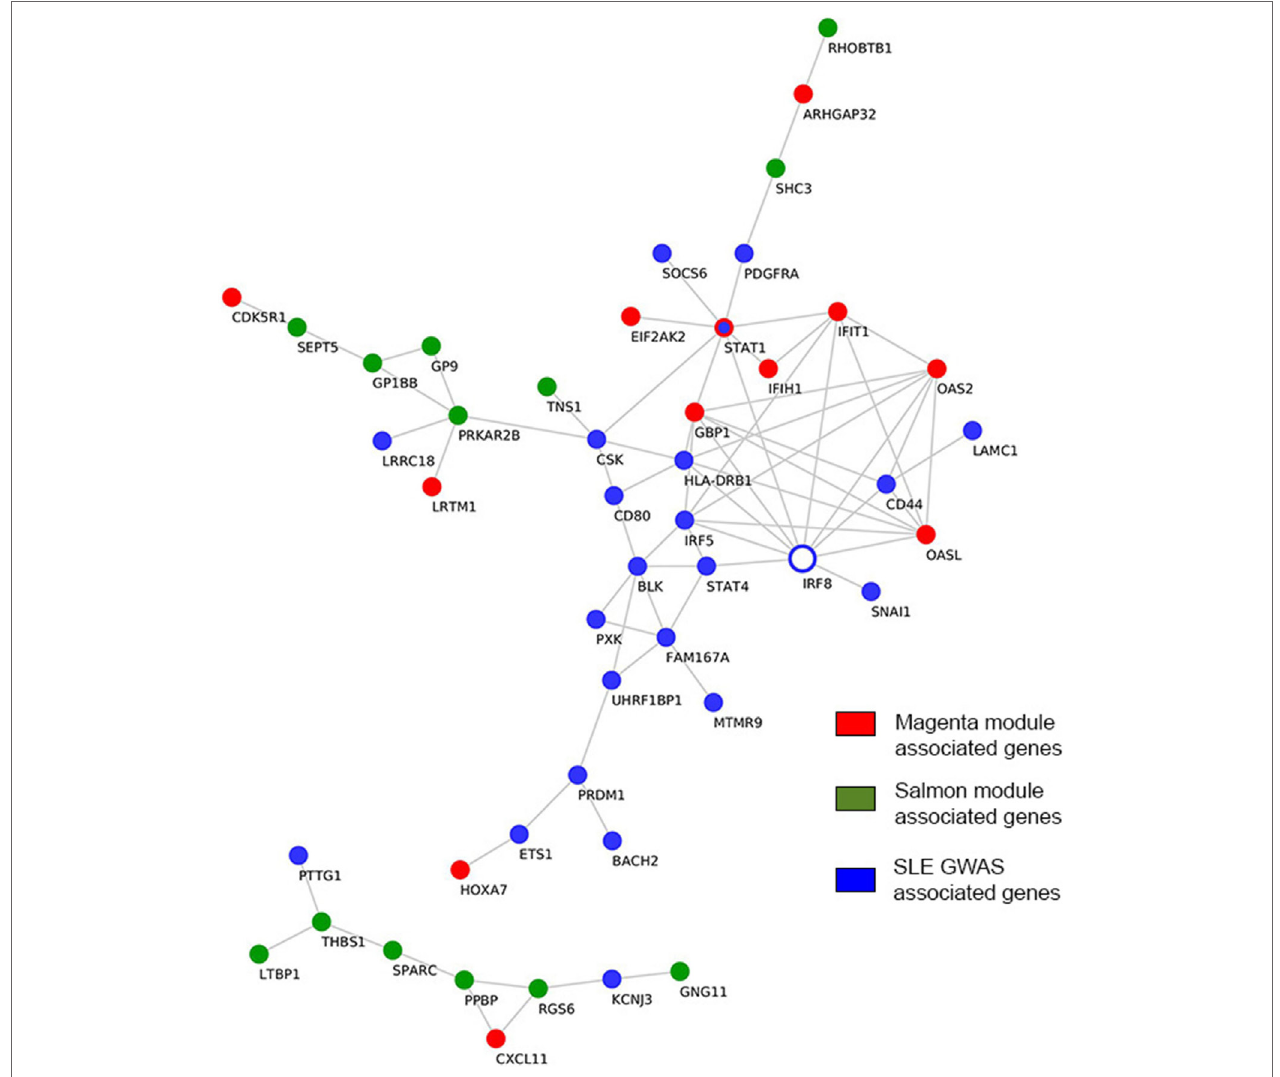
FigUre 5 | Interactions among genome-wide-associated genes and module-derived genes. Direct curated gene–gene interactions between modular genes and genes identified from SLE GWAS. Hub genes are represented by empty blue nodes. Common genes between SLE GWAS and the “magenta” module are denoted in blue nodes with red contour. SLE, systemic lupus erythematosus; GWAS, genome-wide association